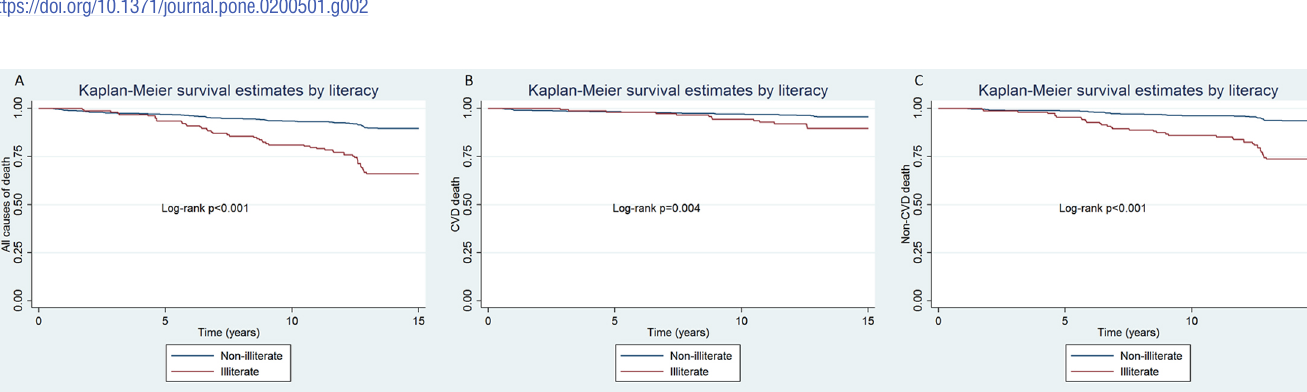
Fig 2. Kaplan-Meier survival curves comparing all causes of death (A), CVD death (B) and Non-CVD death (C) between sub-groups of self-rated health status (poor/fair, good and very